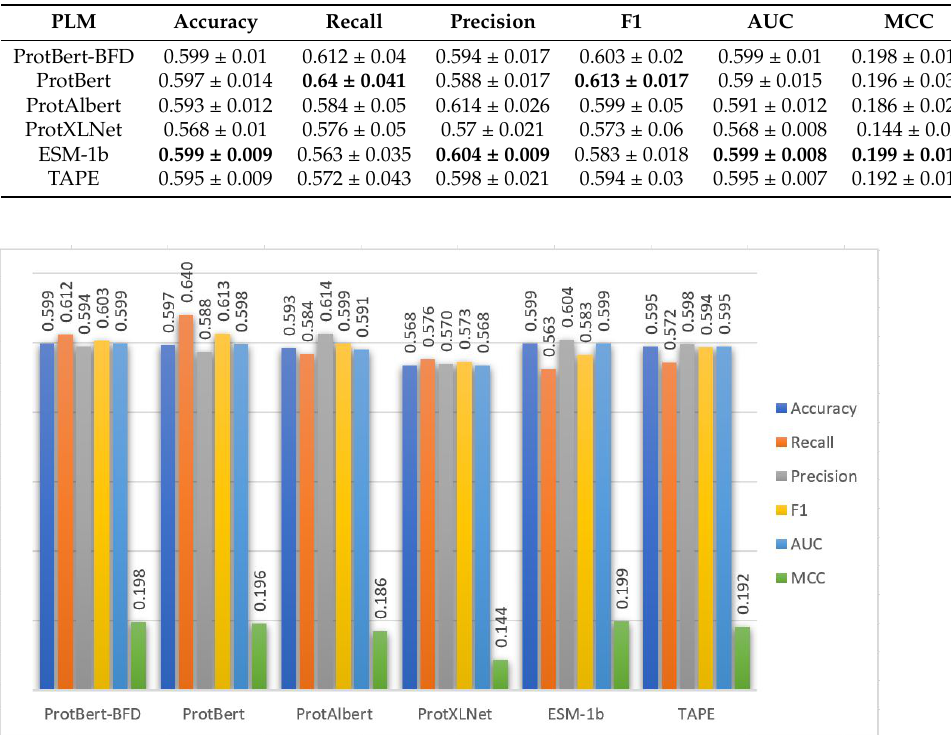
Figure 4. Cross-validation performance results of PTG-PLM on the Kgly training dataset based on the six